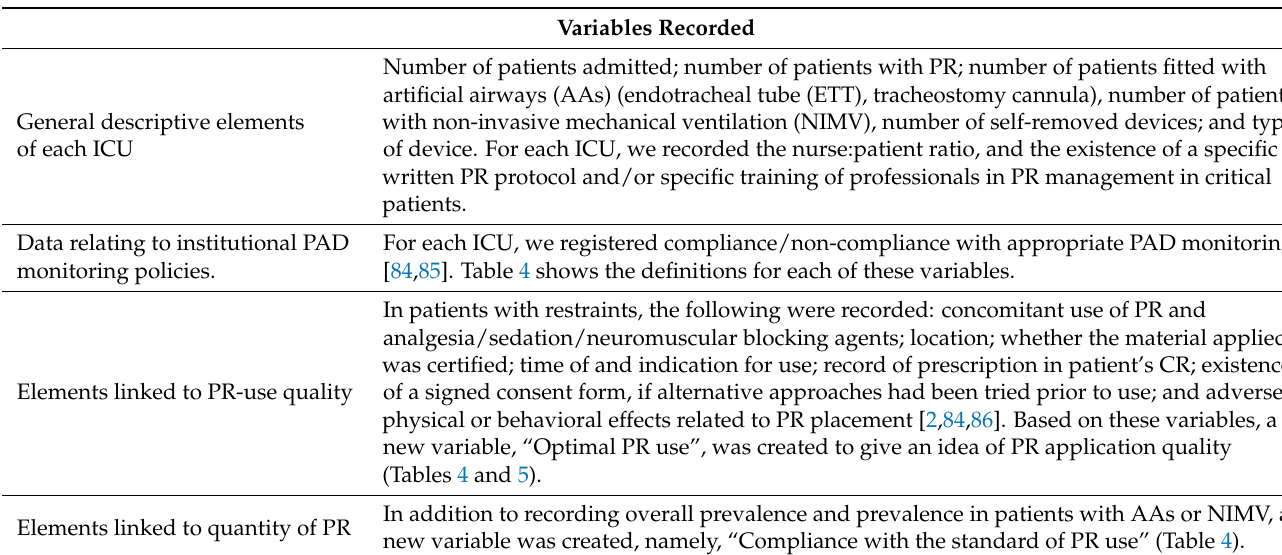
Table 3. Variables recorded in the clinical audit